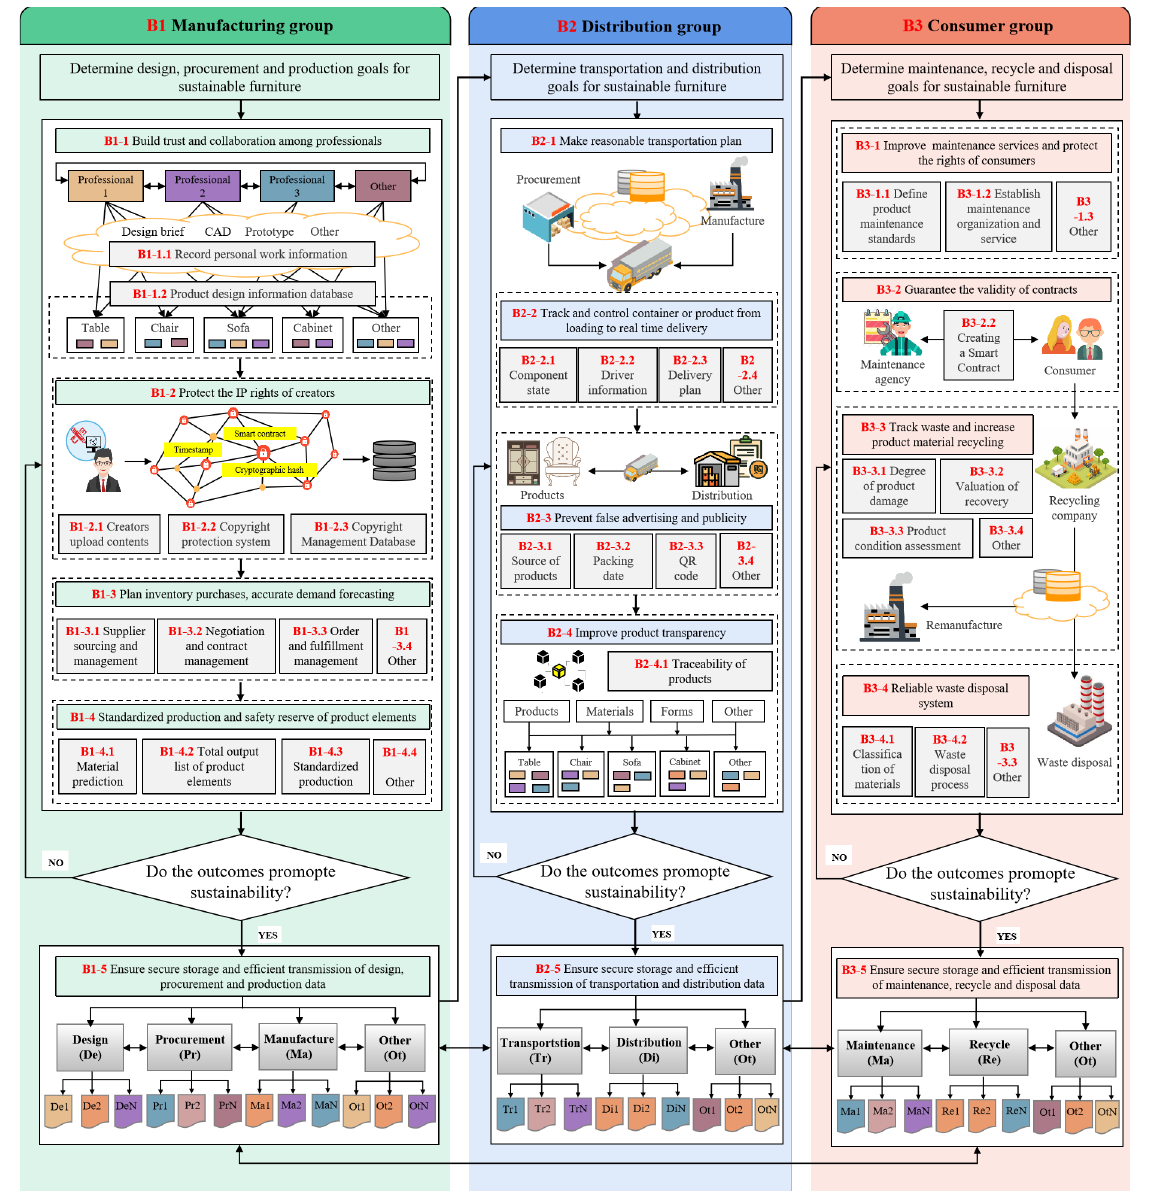
Figure 11. Low-level BC-PSSs framework for sustainable furniture (generated by authors).